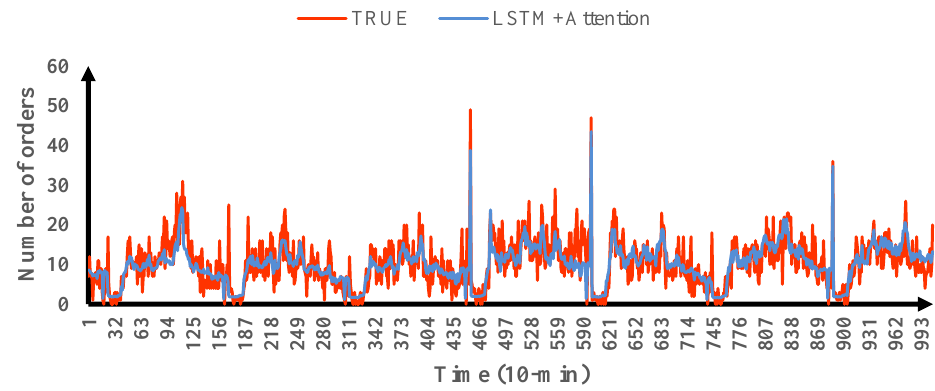
Figure 10. Comparison of 10-min prediction values of LSTM + Attention model.